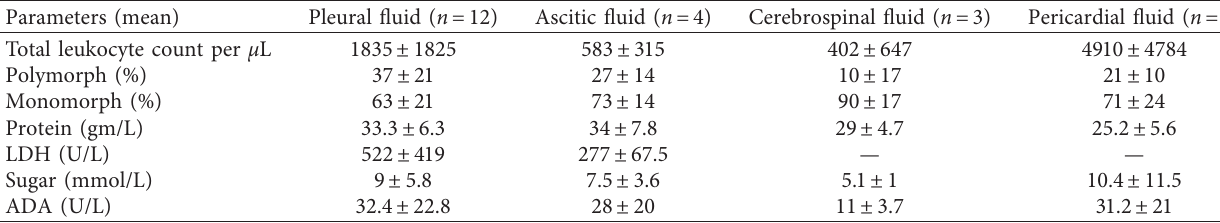
Table 4: Analysis of body fluid in patients with TB and CKD.